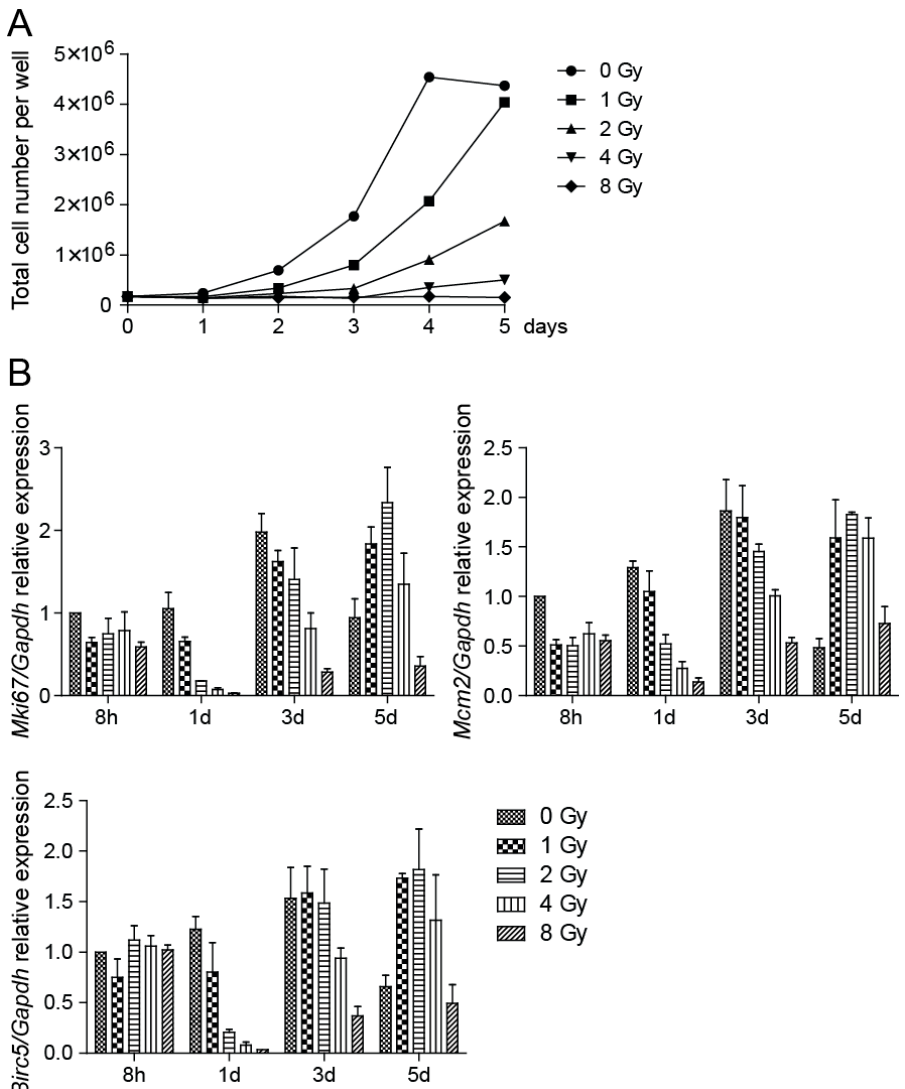
Figure 3. Cell proliferation is impaired by irradiation. ( A ) After irradiation to 0, 1, 2, 4, and 8 Gy doses, cells were counted every day and the total number of cells in control and irradiated plate wells was plotted. ( B ) Quantitative RT-PCR analysis of Mki67, Mcm2 , and Birc5 mRNA expression at 8 h and days 1, 3, and 5 after irradiation to 0, 1, 2, 4, and 8 Gy doses. Gapdh was used as a reference gene. Mki67 : p < 0.0001, Mcm2 : p < 0.0001, Birc5 : p < 0.0001.